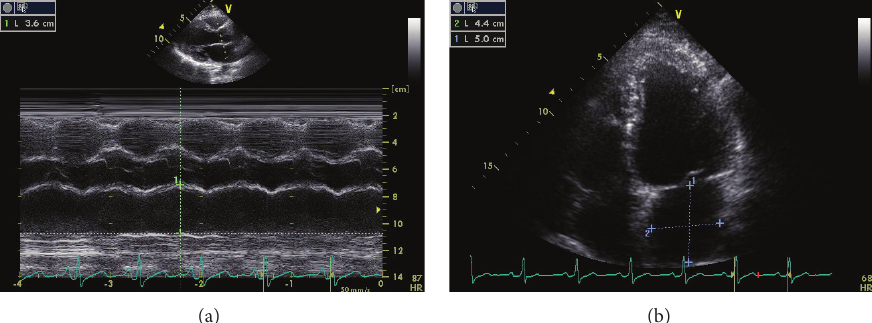
Figure 1: LA dimensions: anteroposterior diameter in parasternal long-axis view (a); longitudinal and transverse diameters in 4-chamber view